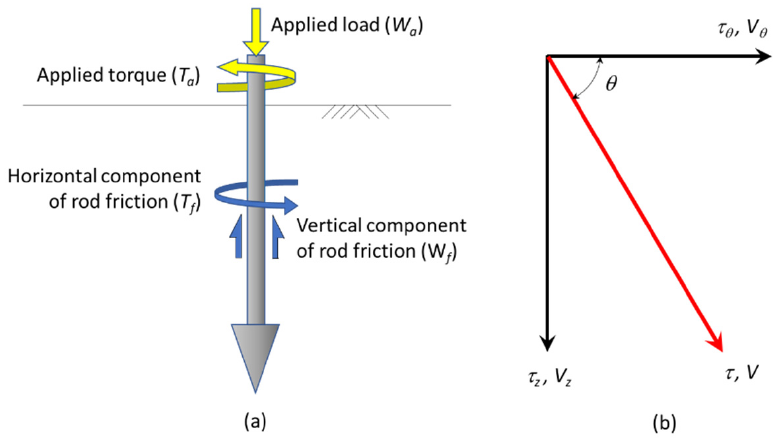
Figure 2. ( a ) Concept of friction acting on the sounding rod; ( b ) estimation of rod friction.